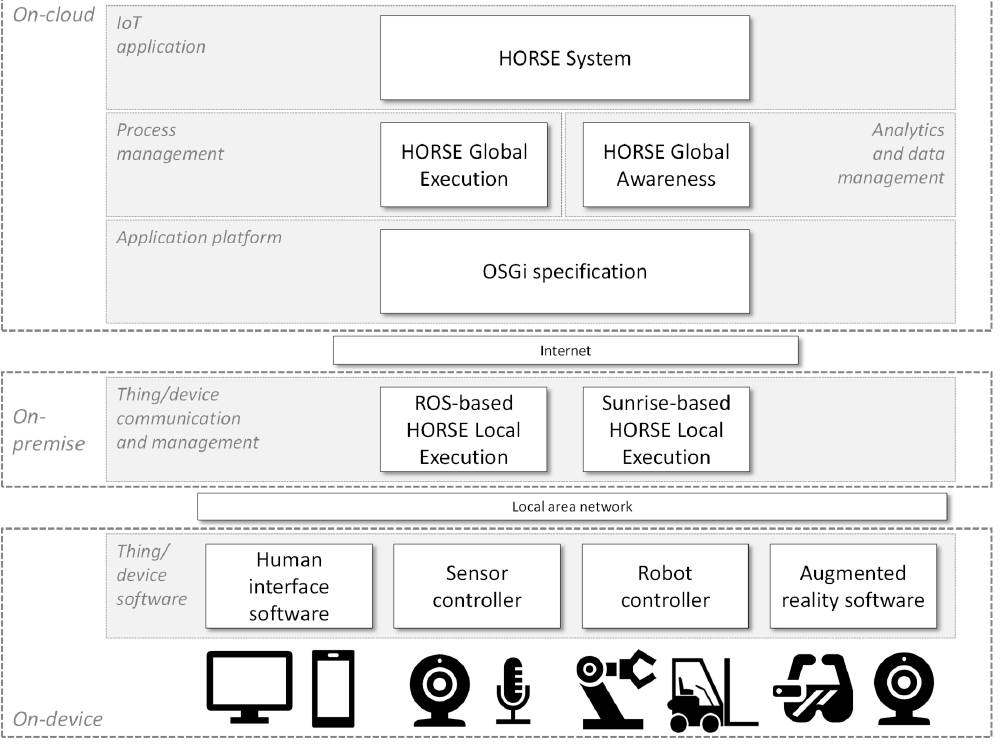
Figure 12. Technology stack showing the HORSE System as an IoT application.